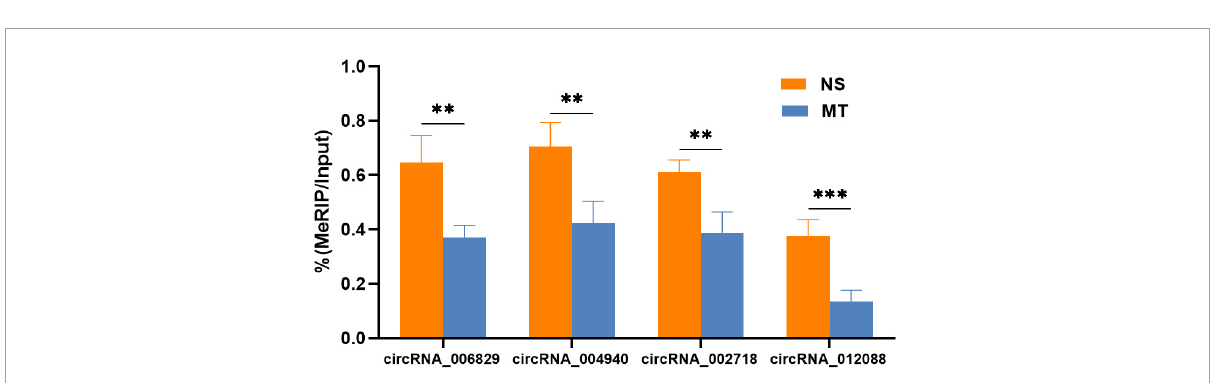
FIGURE5 M 6 A levels of the four circRNAs involved in the circRNA–miRNA networks were verified by MeRIP-qPCR. Relative m 6 A methylation level was calculated as the percentage of modified transcripts in all transcripts. P -values were calculated using Student’s t -test ( n = 4). ∗∗ P < 0.01, ∗∗∗ P < 0.001 compared with the NS group using a two-tailed unpaired Student’s t